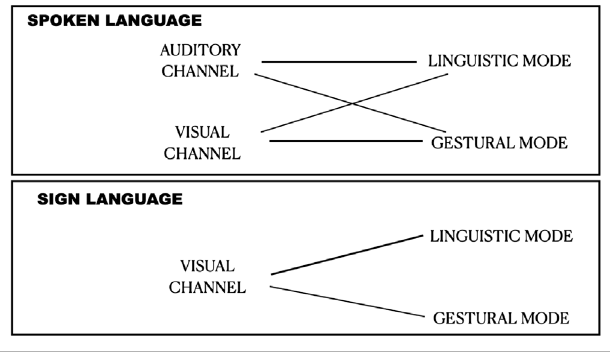
TABLE 2 | The relations between channel and mode in spoken language and in sign